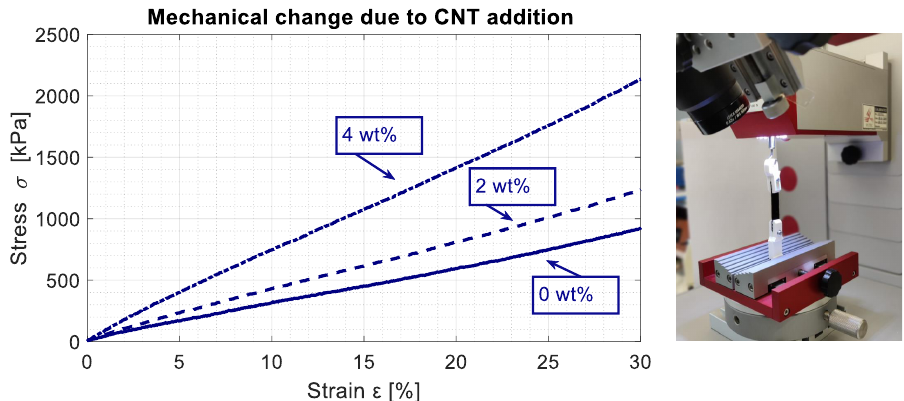
Figure 11. Stress–strain relations for PDMS/CNT samples with different